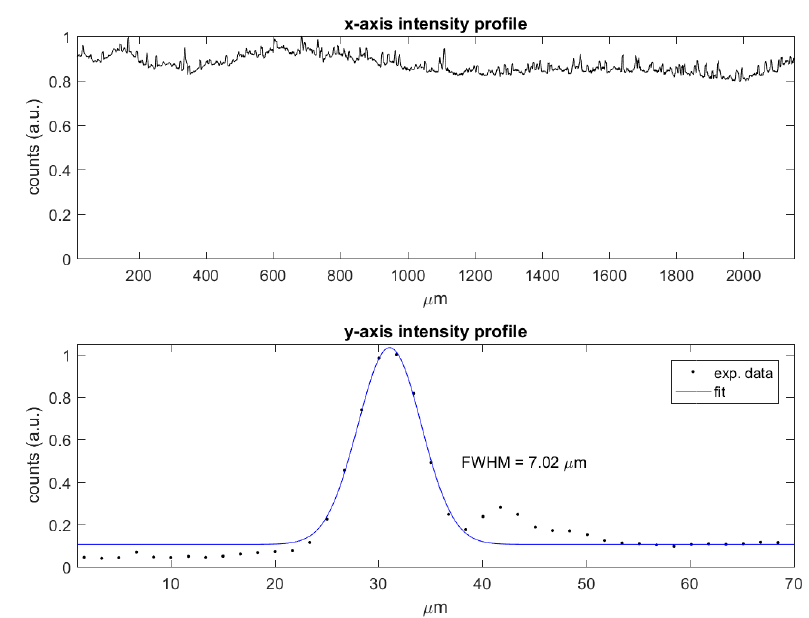
Figure 3. Measured focal distribution, ( bottom ) y-axis profile averaged over 100 µ m on the x-axis and ( top ) 2-mm portion of the x-axis profile averaged over the full y-axis.